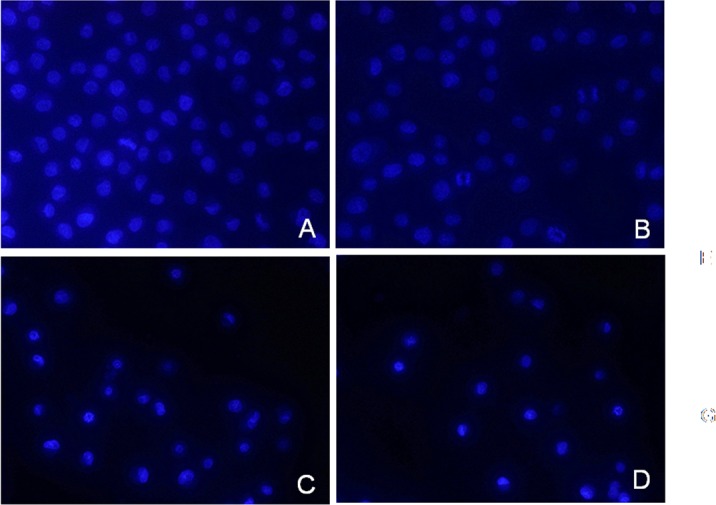
S(MeO)TLC induces Gemcitabine resistance bladder cancer cells apoptosis.A: RT112-Gr cells were left untreated; B: RT112-Gr cells were treated with 45nM Gemcitabine; C: RT112-Gr cells were treated with 0.5μM S(MeO)TLC; D: RT112-Gr cells were treated with both together (45nM Gemcitabine + 0.5μM S(MeO)TLC) for the indicated times and then nuclear morphology was examined with Hoechst staining and visualized by fluorescent microscopy.